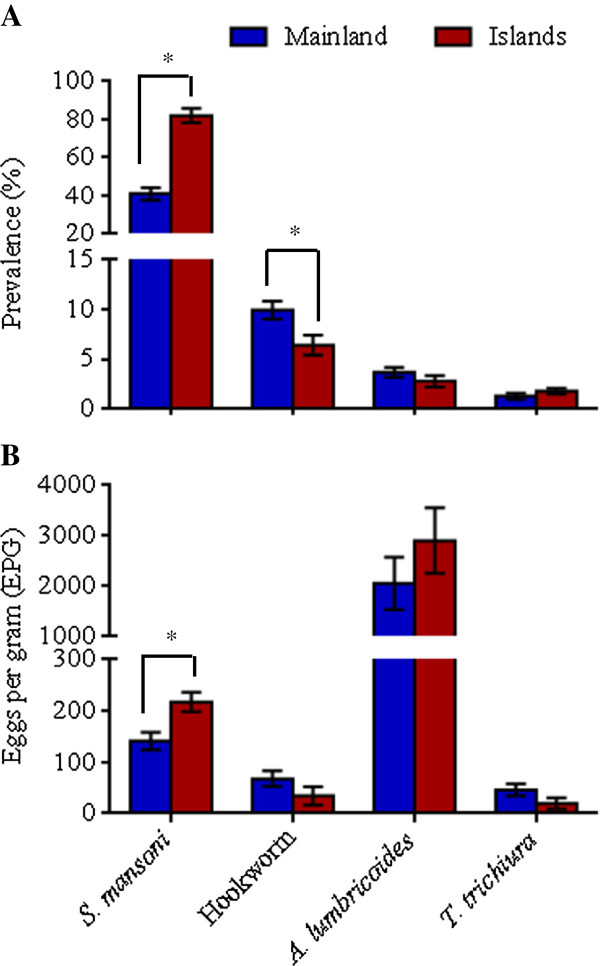
Comparison of prevalence of infection and egg density for helminths between Mbita mainland and islands. Values are mean ± SEM.